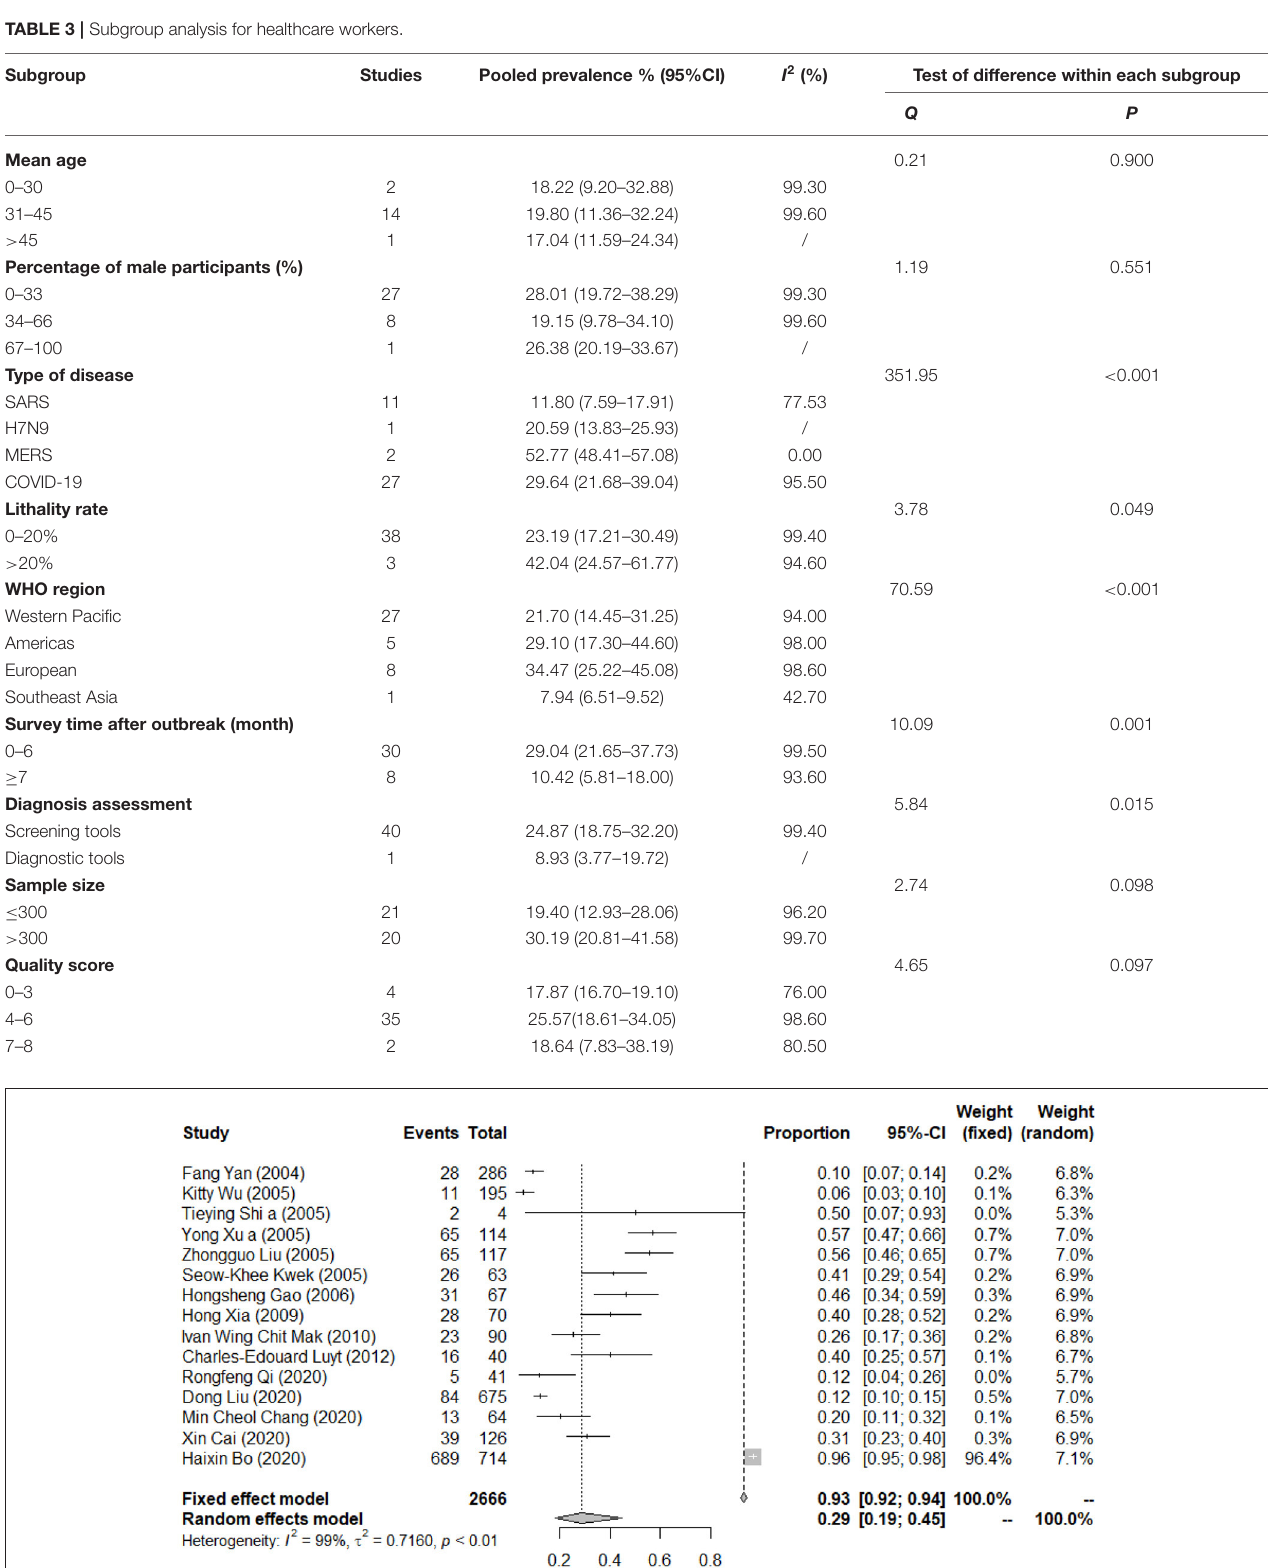
Frontiers in Psychology |